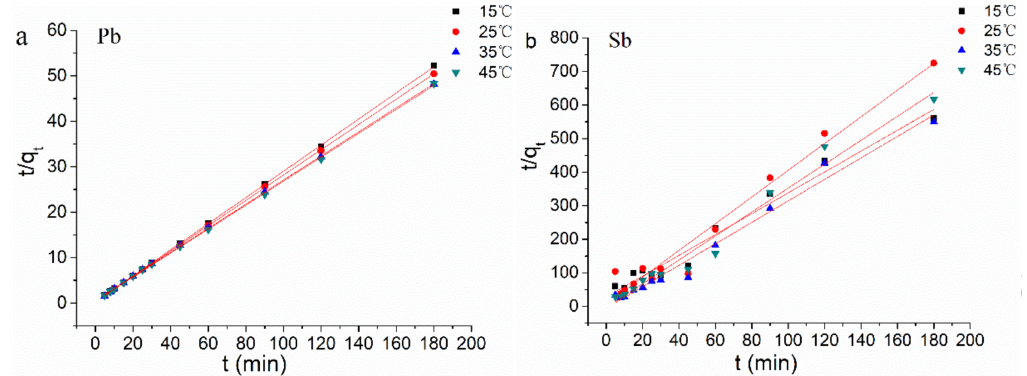
Figure 4. Pseudo-second-order kinetic plots at different temperatures: ( a ) for Pb(II) biosorption and ( b ) for Sb(III)